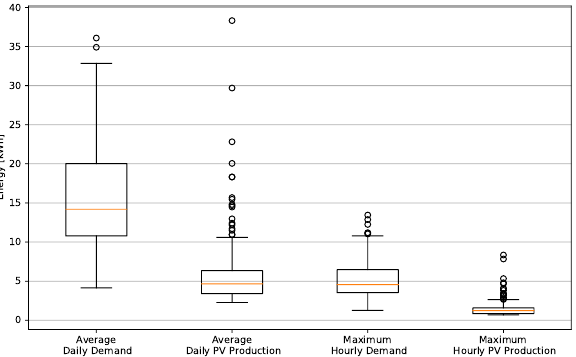
Figure 2. Boxplot of the users’ average daily and maximum hourly demand and production.